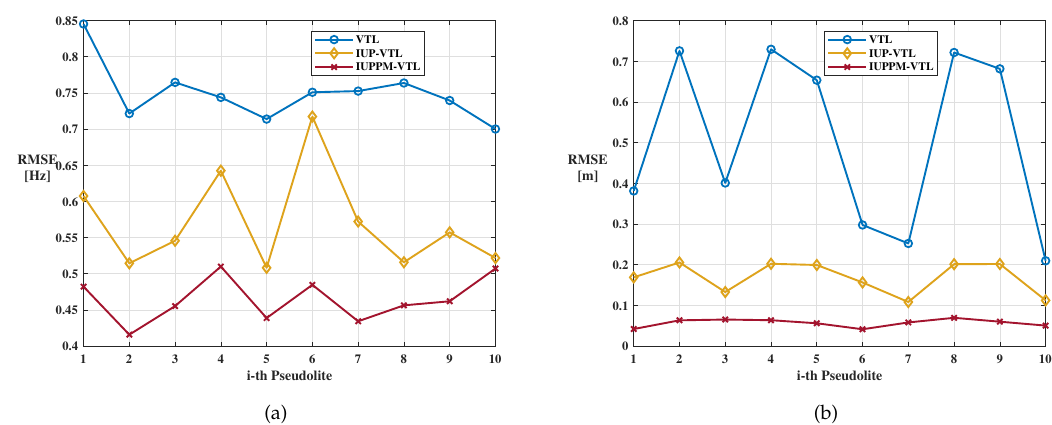
Figure 11. Tracking results of all pseudolites. ( a ) Doppler error of all pseudolites. ( b ) Code phase error of all pseudolites.